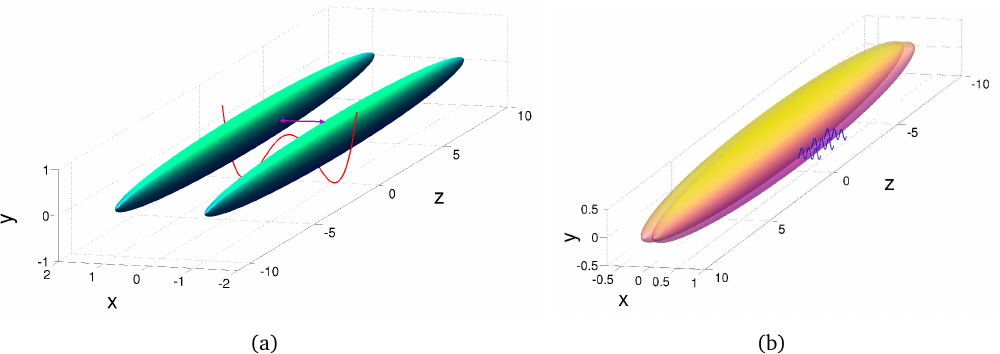
Figure 1: Possible realisations of a linearly-coupled two-component Bose gas as described by Eqs. (1) and (6). (a) A scalar Bose gas confined in an elongated double-well potential. A tight binding approximation leads to Eq. (1), where J describes tunneling through the potential = 0, γ = 1). (b) An atomic Bose gas with two barrier and the cross-interaction vanishes ( g c accessible (hyperfine) spin components in a cigar-shaped quasi-one-dimensional trap. The two components are slightly off-shited for clarity. Linear coupling of the spin-components with constant J is achieved by coherent driving with a radio-frequency field shown in blue. In ≈ g , this case, the cross-component interaction g is typically of similar magnitude to g ( g c c | γ | (cid:28) 1) but can be tuned to different values by means of a Feshbach resonance for certain atomic species [ 41,45 ]